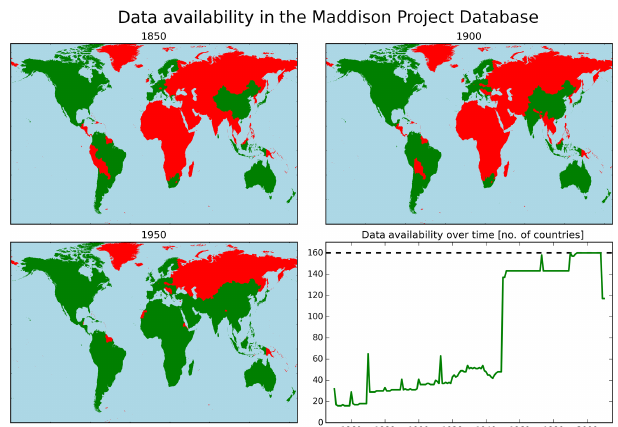
Figure 1. Illustration of data availability in the Maddison Project Database over time. Maps show the geographical distribution of available data points for 3 selected years (1850, 1900, 1950), while the plot displays the actual number of available countries over the full period. Countries are displayed using their current borders. We only show data for those 160 countries that are explicitly named in the Maddison Project Database; country group estimates lacking national resolution are not shown (see Table 2 for